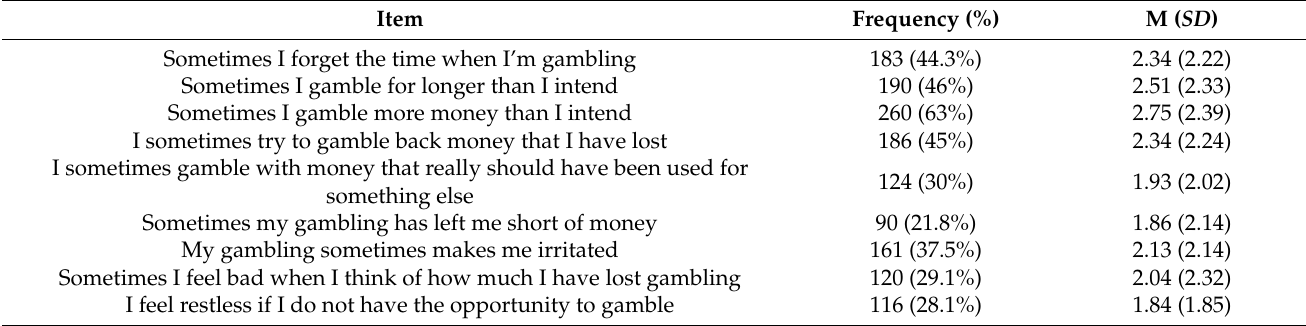
Table 2. Frequencies, Means, and Standard Deviations for the GamTest after reducing the misfit items (9 items) a